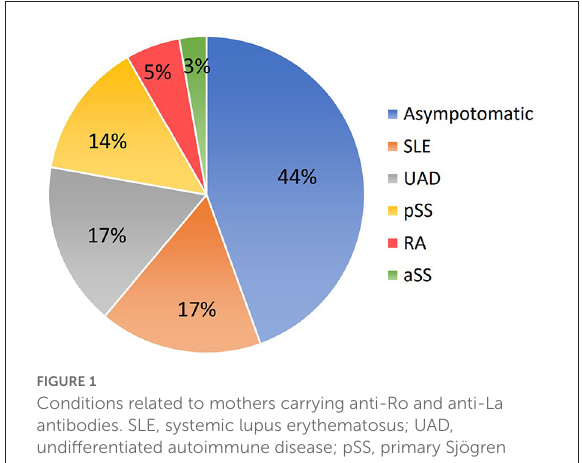
FIGURE2 Distribution of endocardial fibroelastosis in fetuses with cardiac complications due to maternal anti-Ro and anti-La antibodies. PM, papillary muscle; LA, left atrium; RA, right atrium; MV, mitral valve; TV, tricuspid valve; AV, aortic valve; PV, pulmonary valve; RV, right ventricle; LV, left